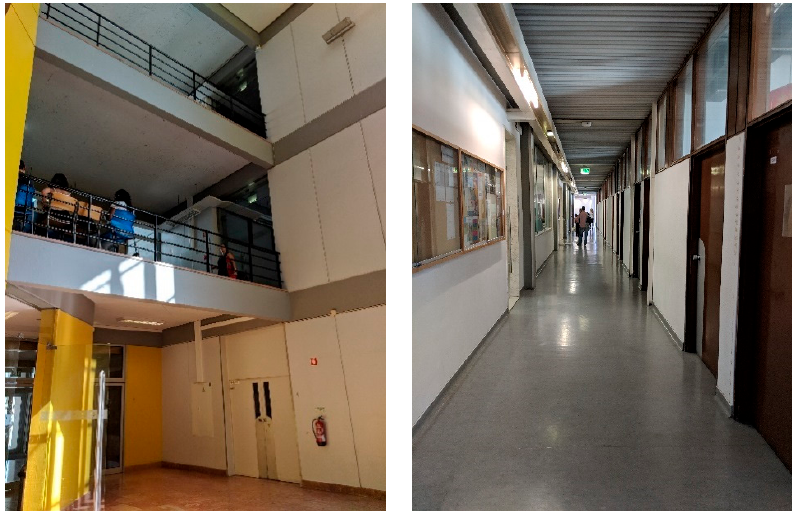
Figure 4. Signal propagation test locations: mezzanine ( Left ) and corridor ( Right ).